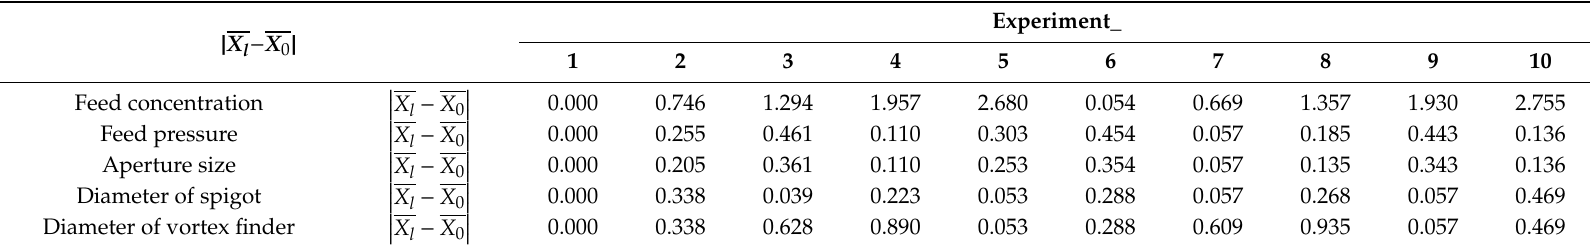
Table A2. Discrepancy of Grey System theory for TPHS.